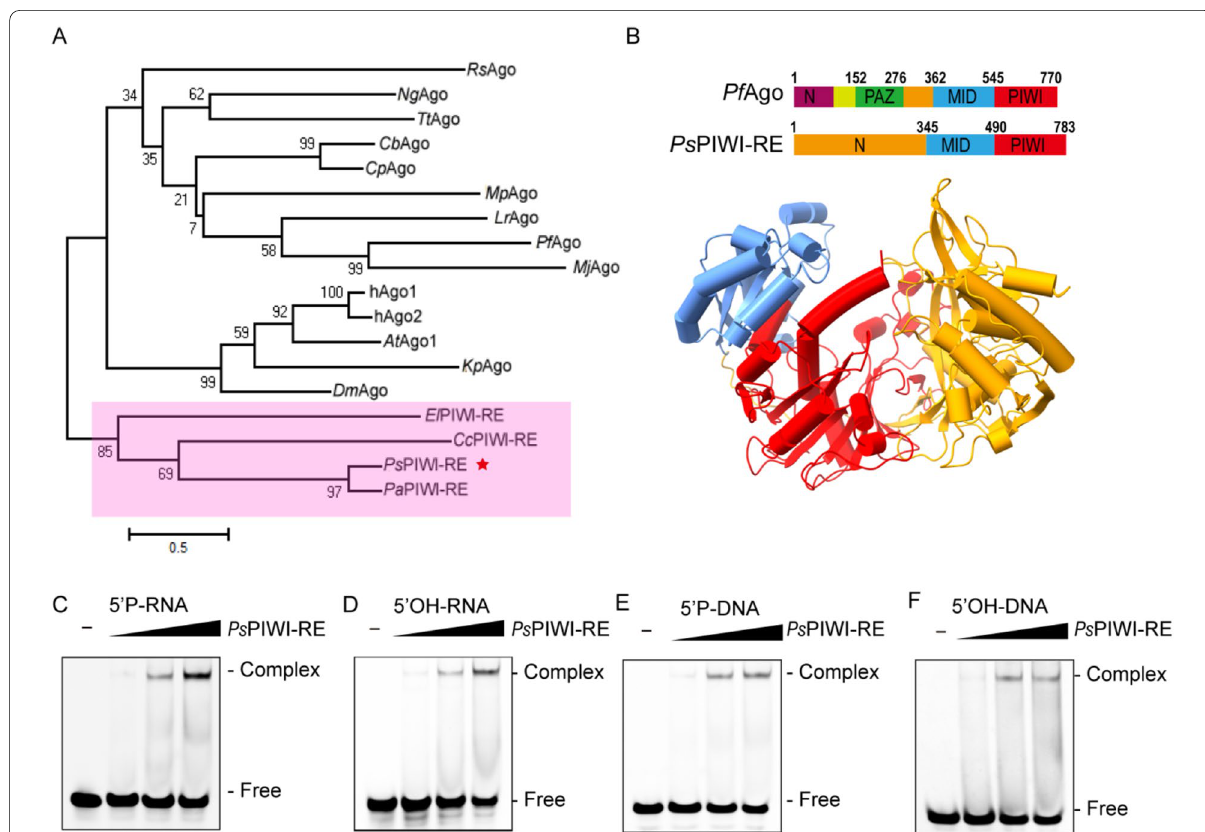
Fig. 1 Ps PIWI-RE is a distinct group of PIWI-RE with a unique N-domain that binds various guide strands. A Phylogenetic analysis of pAgo and PIWI-RE proteins. Phylogenetic tree generated by the Maximum Likelihood method of MEGA4. We computed 1000 replicates for bootstrap support. The pink area represents the PIWI-RE family and the red star indicates Ps PIWI-RE. B Domain architecture analysis of Ps PIWI-RE predicted by AlphaFold 2 reveals that Ps PIWI-RE contains a unique N-domain, MID domain, and PIWI domain. C – F Binding affinities of four types of different guides to